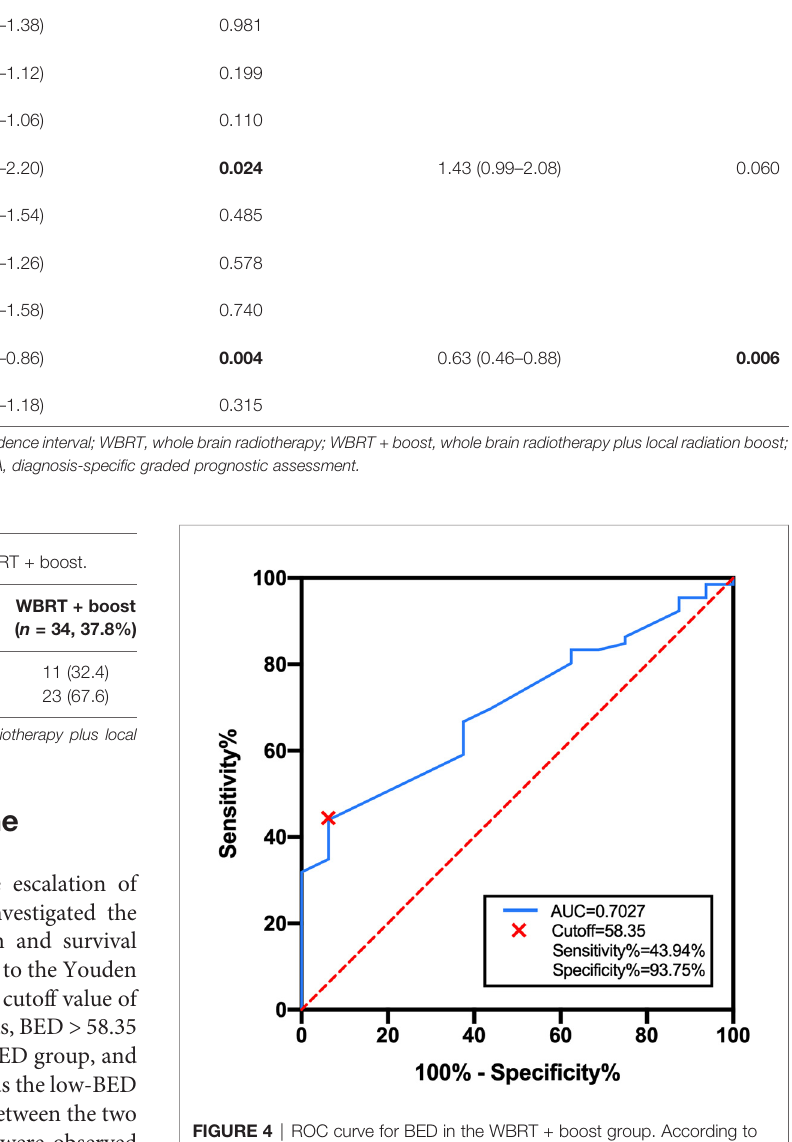
FIGURE 4 | ROC curve for BED in the WBRT + boost group. According to the Youden index of 0.376, 58.35 Gy was taken as the optimal cutoff value with a sensitivity of 44.94% and a speci fi city of 93.75%. Area under the curve was 0.703 (95% CI: 0.589 – 0.825, p = 0.012).